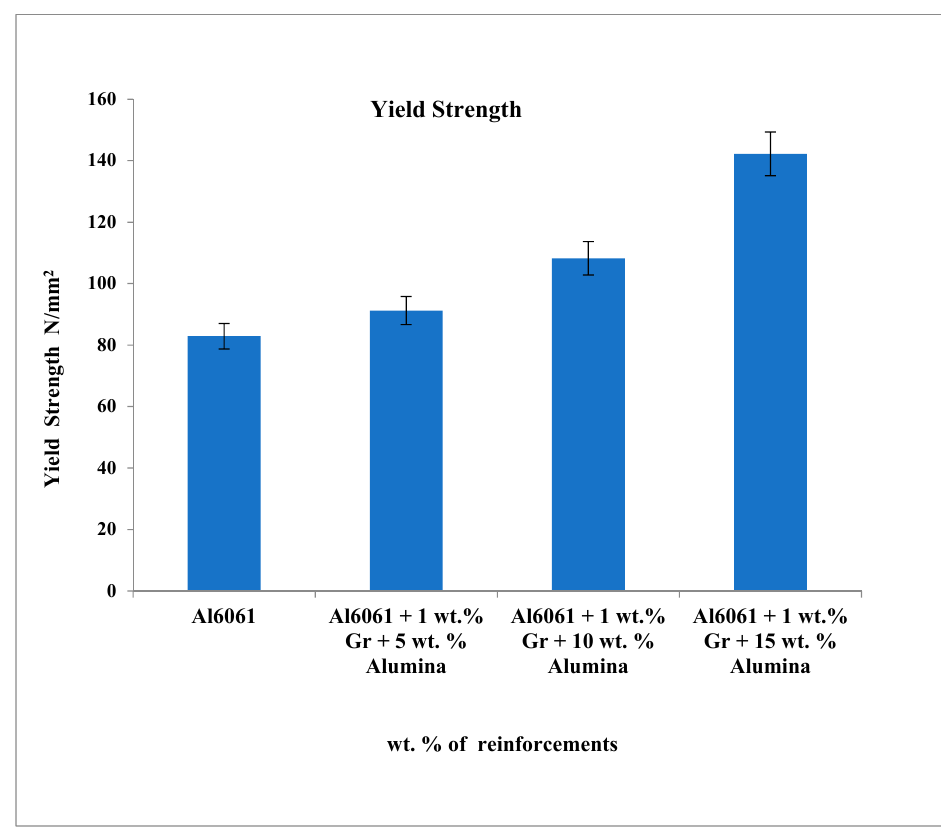
Figure 4. YS variation in hybrid Al6061-Al 2 O 3 -Graphene composites .